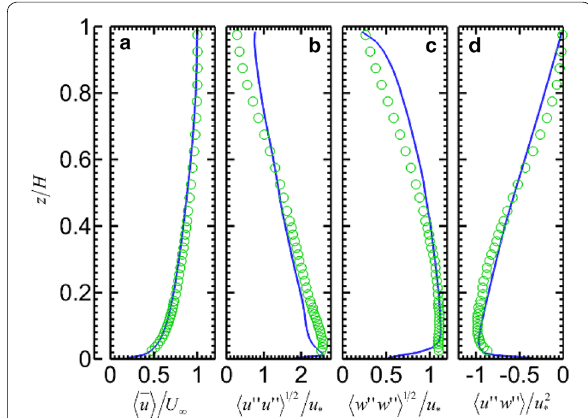
Fig. 2 Vertical profiles of a mean wind speed; b streamwise fluctuating velocity; c vertical fluctuating velocity; d vertical momentum flux. Solid line: LES data; symbols: wind‑tunnel data (Ho and Liu